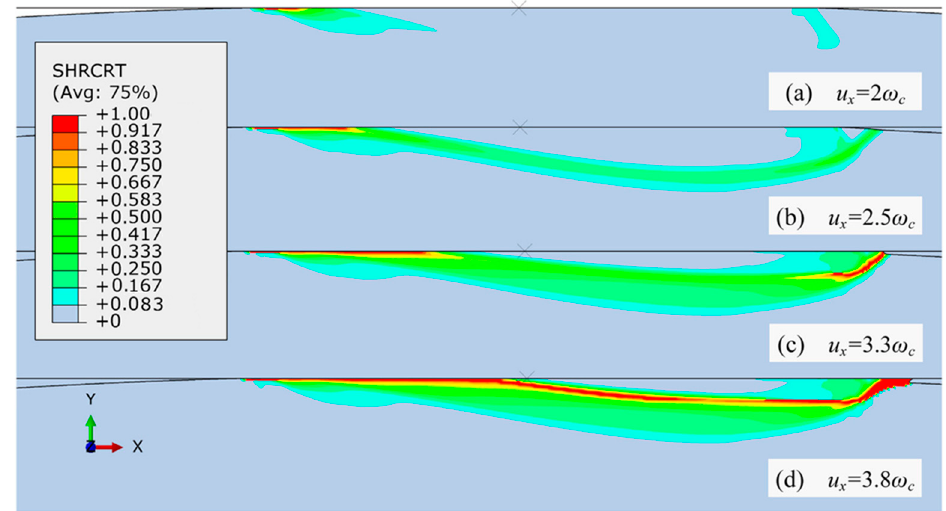
Figure 1. Development of the fracture initiation during tangential loading of u x . Taken from [41].